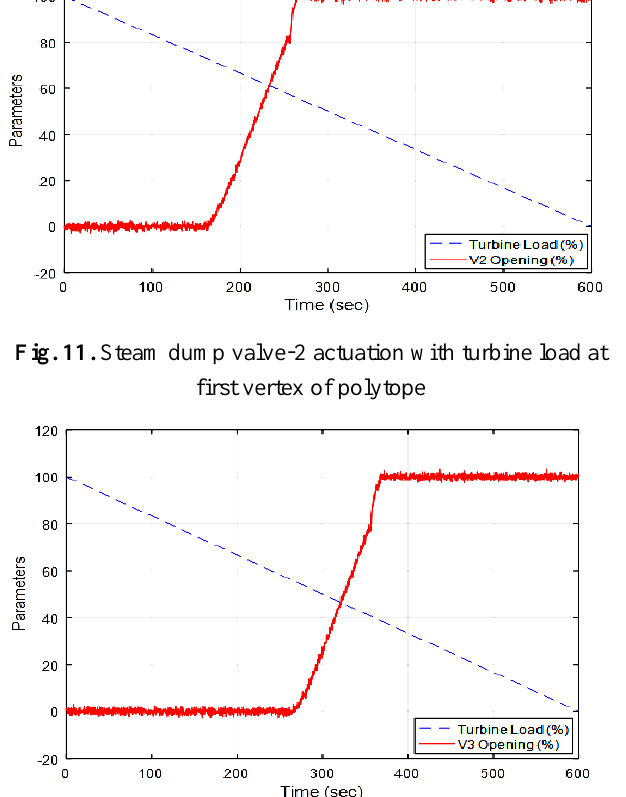
Fig. 12. Steam dump valve-3 actuation with turbine load at first vertex of polytope